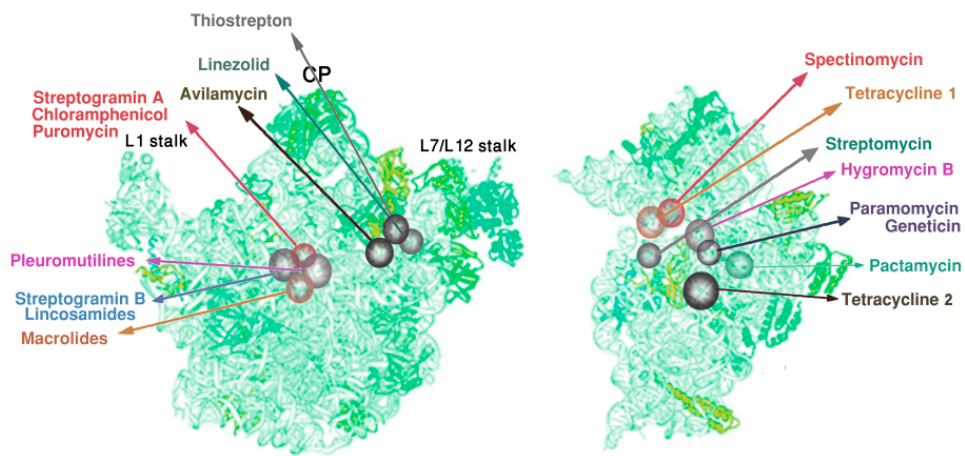
Figure 2. Main antibiotics binding sites shown on the skeletons of the large ( left ); and the small ( right ) ribosomal subunits.